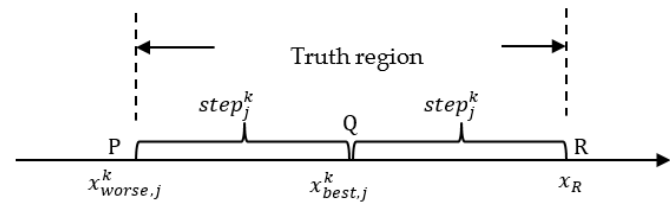
Figure 1. Schematic diagram of position update.